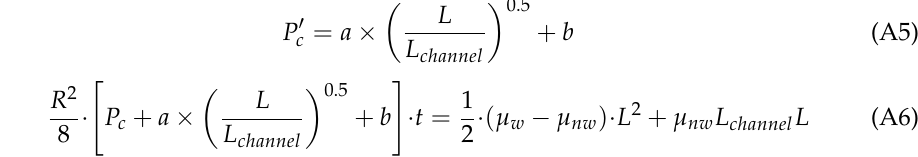
Equation (A6) is a modified model considering the third force at the angle outside the single channel. The values of characteristic parameters a and b can be obtained by the curves of time and distance in the imbibition process, and then a modified Poiseuille model for imbibition of water-displacing-oil can be obtained, which can be used to predict the imbibition process under the same